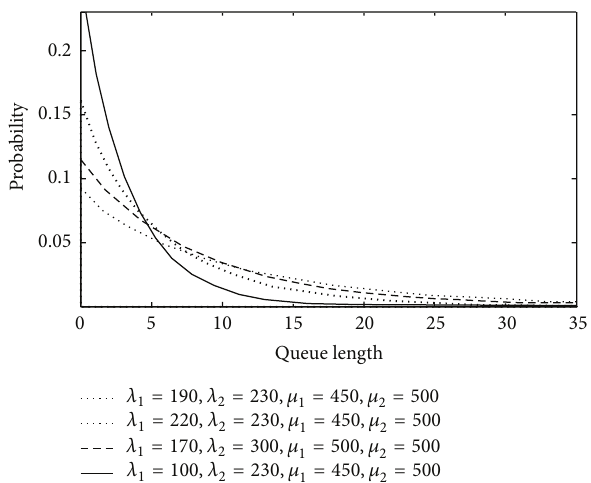
Figure 6: Probability and queue length